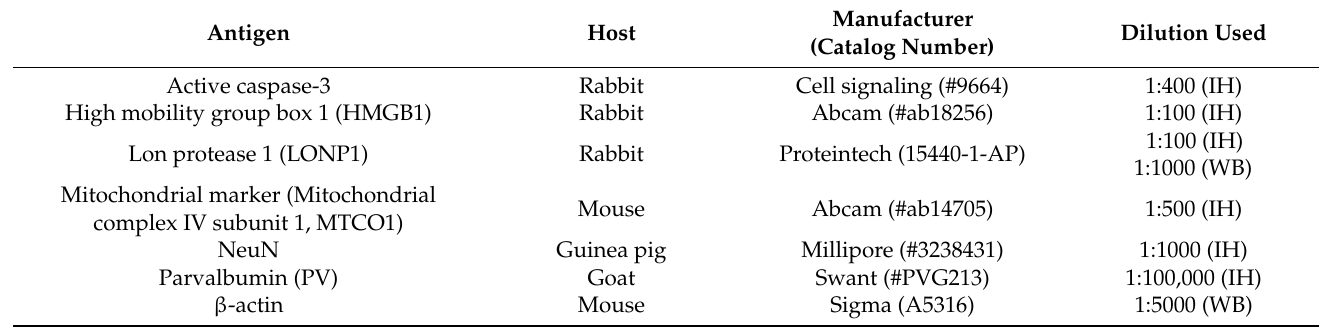
Table 1. Primary antibodies used in the present